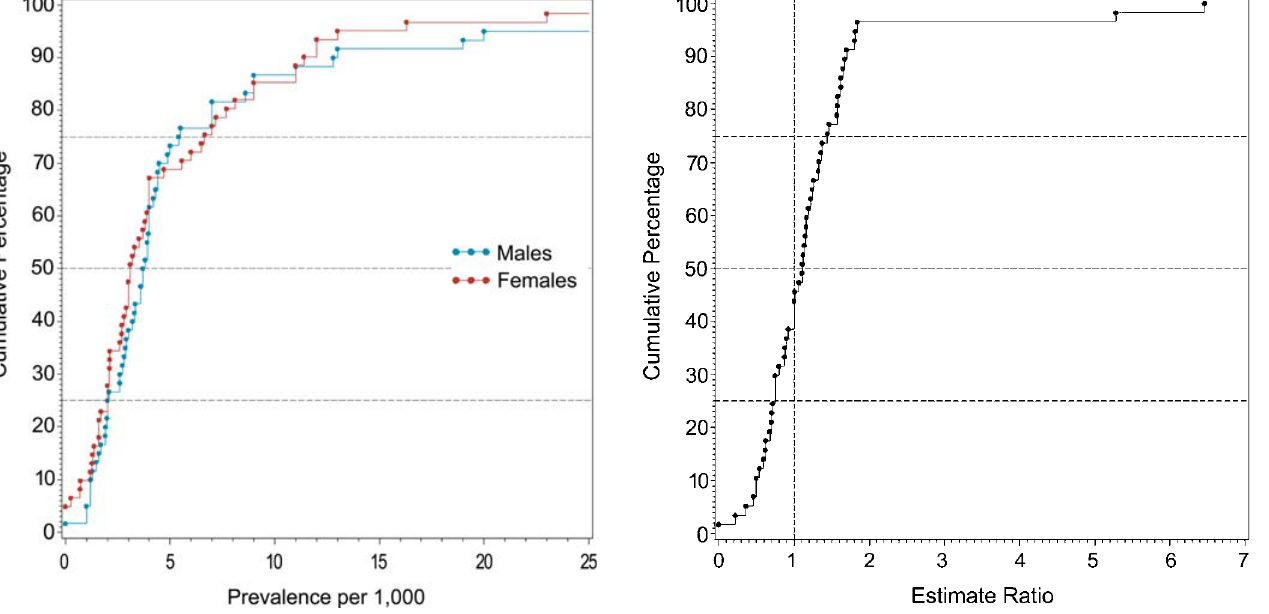
Figure 8. Cumulative Plots of Combined Prevalence Estimates per 1,000 by Sex DOI: 10.1371/journal.pmed.0020141.g008